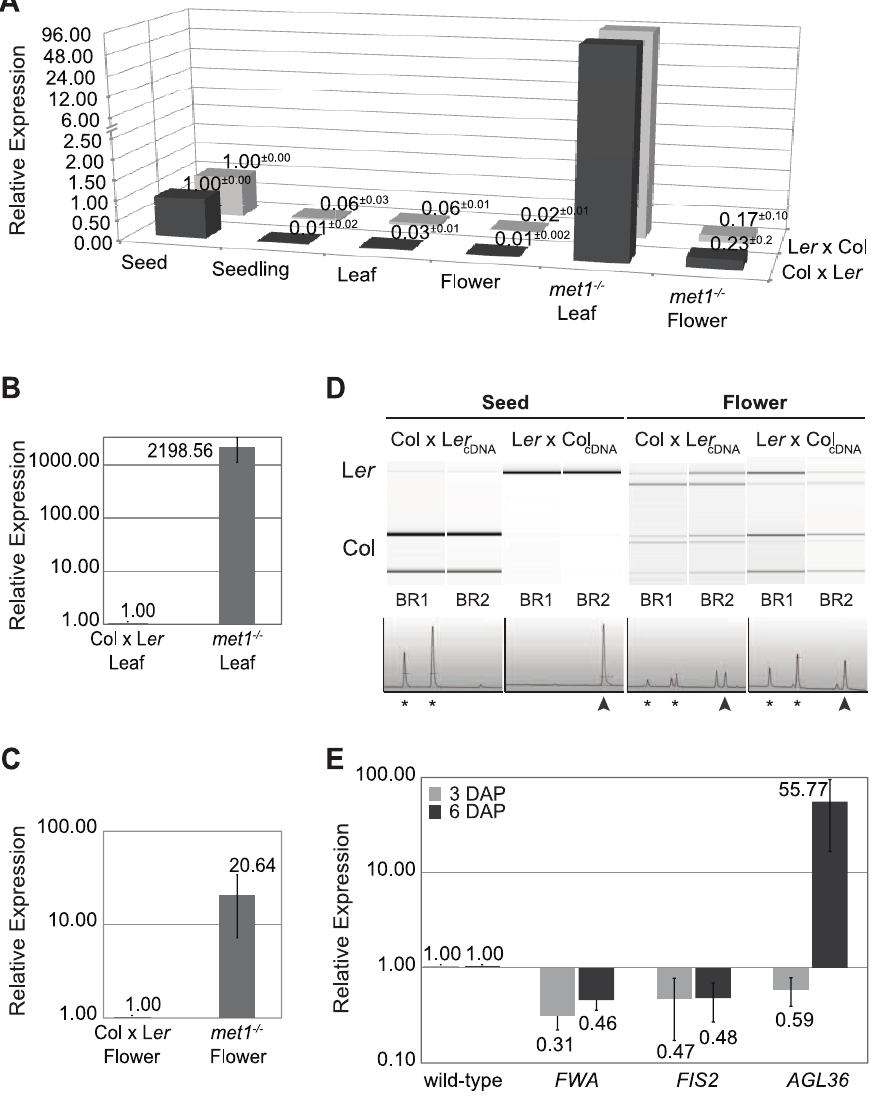
Figure 6. AGL36 expression is controlled by MET1 and DME. (A) Real-time PCR of AGL36 expression levels in seeds, seedlings, leaves and flowers in F1 progenies of L er x Col (gray bars), and Col x L er (black bars) plants. AGL36 expression level in leaves and flowers of met1 2 / 2 selfed plants in the Col ecotype are shown in the two rightmost bars. All expression levels shown are relative to the AGL36 expression levels in 3 DAP seeds. (B–C) Expression levels of AGL36 in leaves (B) and flowers (C) of met1 2 / 2 plants (Col) relative to expression level in F1 progenies of Col x Ler plants. (A–C) represent the average relative expression values obtained from two independent biological parallels (BR) where each gave rise to four independent cDNA syntheses (TR). STDEV is derived from the two BRs. ACT11 is the reference gene used. (D) Parental dependence of AGL36 expression in seeds and flowers. SNP analyses of 3 DAP seeds (left) and F1 hybrid flowers (right) obtained from Col x L er and L er x Col crosses. The amplified SNP containing region of AGL36 was Alw NI digested and analyzed in a Bioanalyzer. Seeds express AGL36 only from the maternal genome (left). Flowers express AGL36 biparentally (Note both L er and Col bands (right)). The electropherograms represent one BR. Peaks are representing the bands shown in the graph. Asterisk; digested Col product, Arrowhead; undigested L er product. (E) Real-time PCR expression levels of FWA , FIS2 and AGL36 in dme-6 x Col vs. wild-type seeds 3 and 6 DAP. Graphs represent the average relative expression from four independent BRs. Values for FIS2 are calculated based on 3 BRs as the value for the fourth BR was clearly out of range. Samples used in the first BR gave rise to two TRs. STDEV is derived from the independent BRs. ACT11 is the reference gene used.